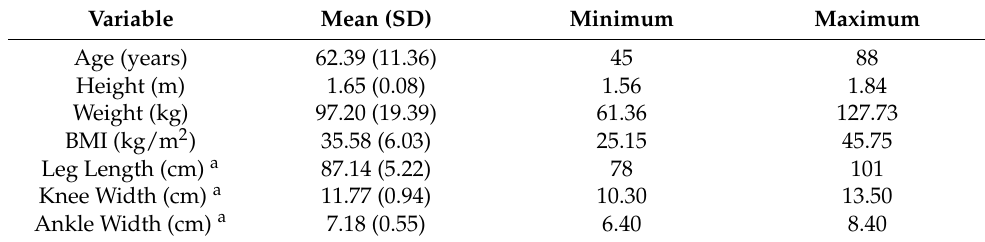
Table 1. Descriptive data for participants.